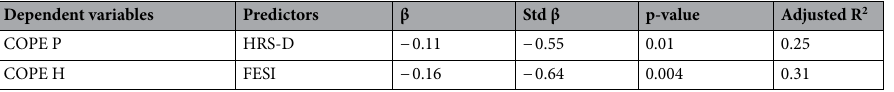
Table 2. Backward linear regression: significant predictors on each subscale of Erbans. β regression coefficient, Std β standardized regression coefficient, HRS-D Hamilton rating scale for depression, FESI Falls